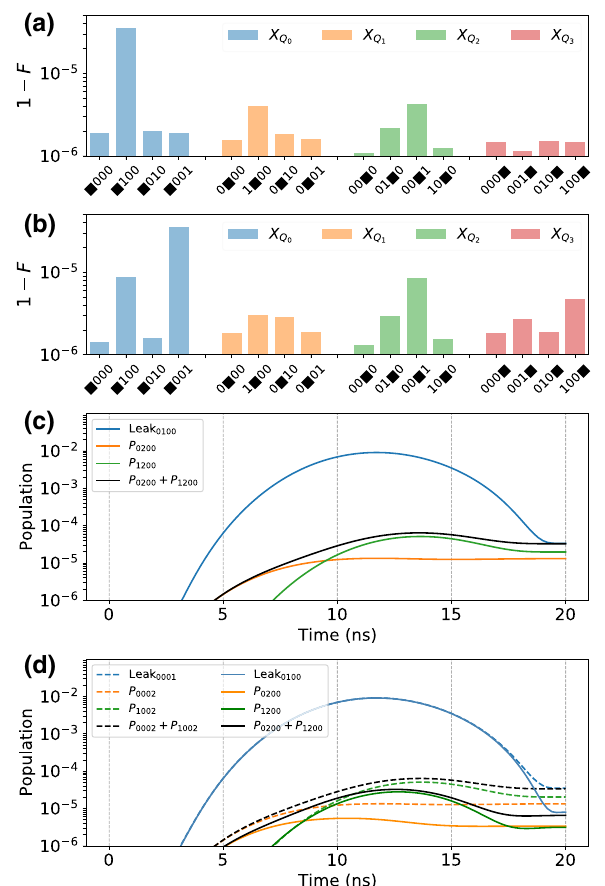
FIG. 7. X gate error with the other three spectator qubits in four different state configurations, e.g., marked by { (cid:2) 000, (cid:2) 100, (cid:2) 010, (cid:2) 001 } for Q 0 . (a) For the four-qubit chain system shown in Fig. 5(b). (b) For the four-qubit square system shown in Fig. 5(c). (c),(d) State population as a function of time during the isolated single-qubit operations in the four-qubit chain system and square system. Solid lines (dashed lines) denote the result for the four-qubit system initialized in | 0100 (cid:2) ( | 0001 (cid:2) ). The leakages are defined as Leak 0100 = 1 − ( P 0100 + P 1100 ) , Leak 0001 = 1 − ( P 0001 + P 1001 ) , where P ijkl represents the population in the four-qubit state | ijkl (cid:2)